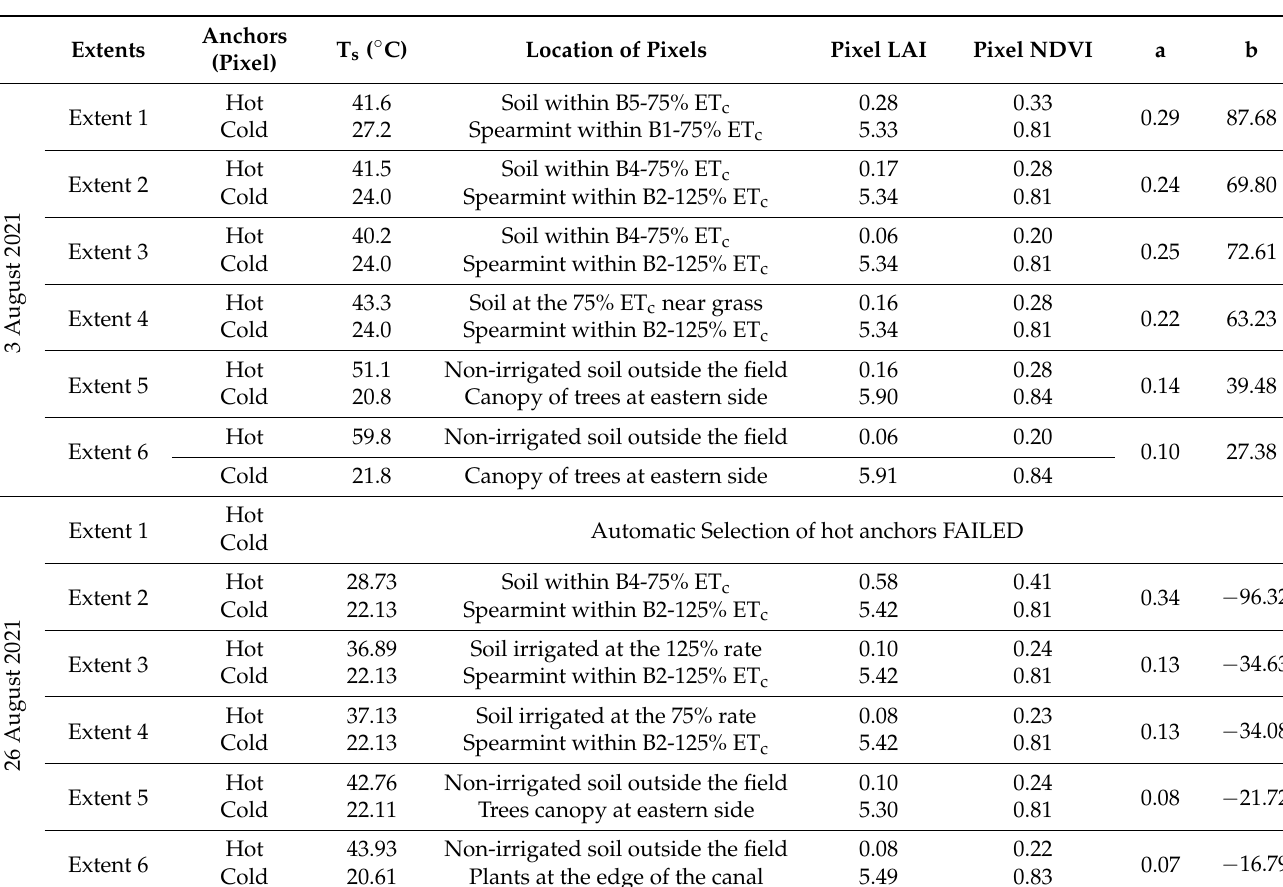
Table 1. Summary details of selected hot and cold anchor pixels of the UAS-METRIC model in two days of August